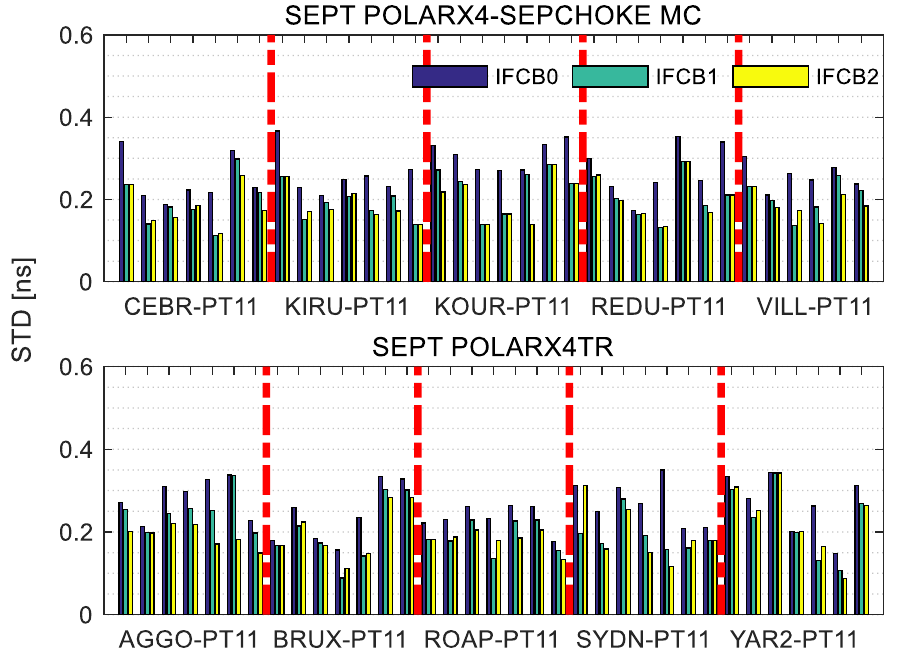
Figure 5. Distribution of the standard deviations (STDs) of the clock differences of some stations selected from the stations equipped with the identical receivers ( top ) and mixed receivers ( bottom ).